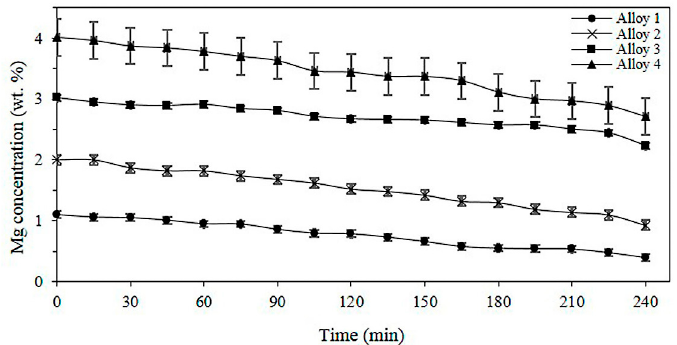
Figure 4. Variation in the concentration of Mg during the aluminothermic reduction of Mn 2 O 3 to 1073 K and 240 rpm of agitation speed, for the indicated alloys.